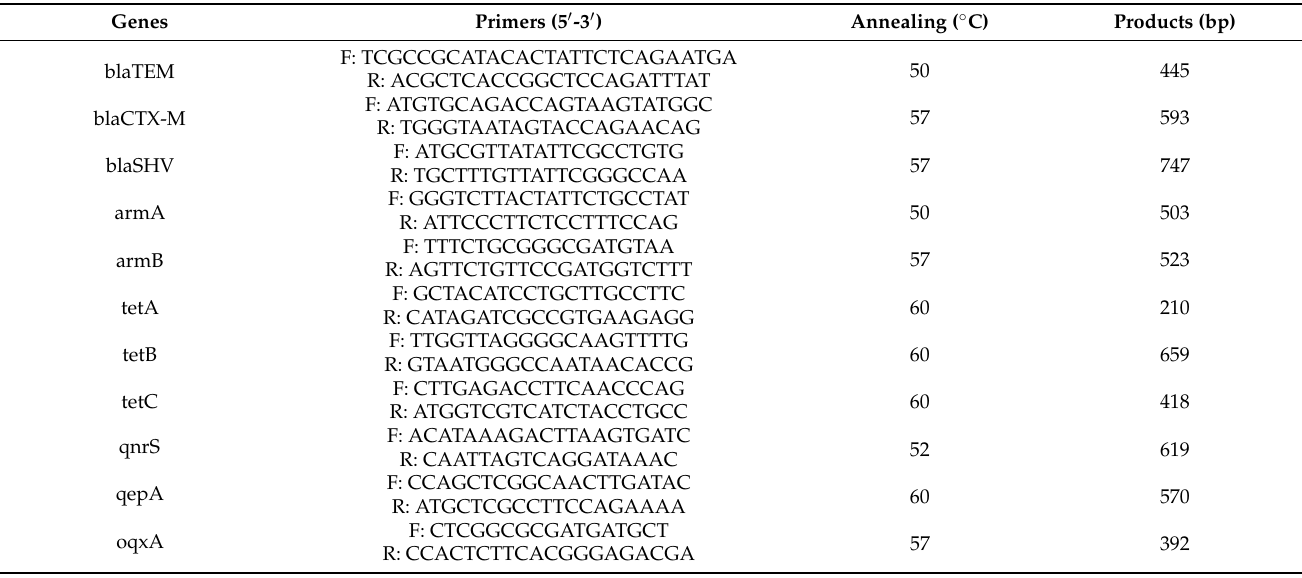
Table 1. Primers designed for the PCR